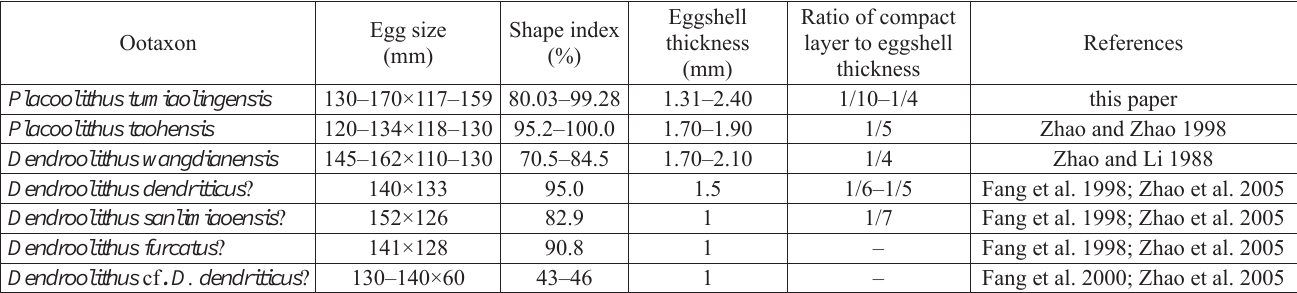
Table 2. Comparison of the eggs from the Tumiaoling Hill and other known dendroolithid eggs in China.